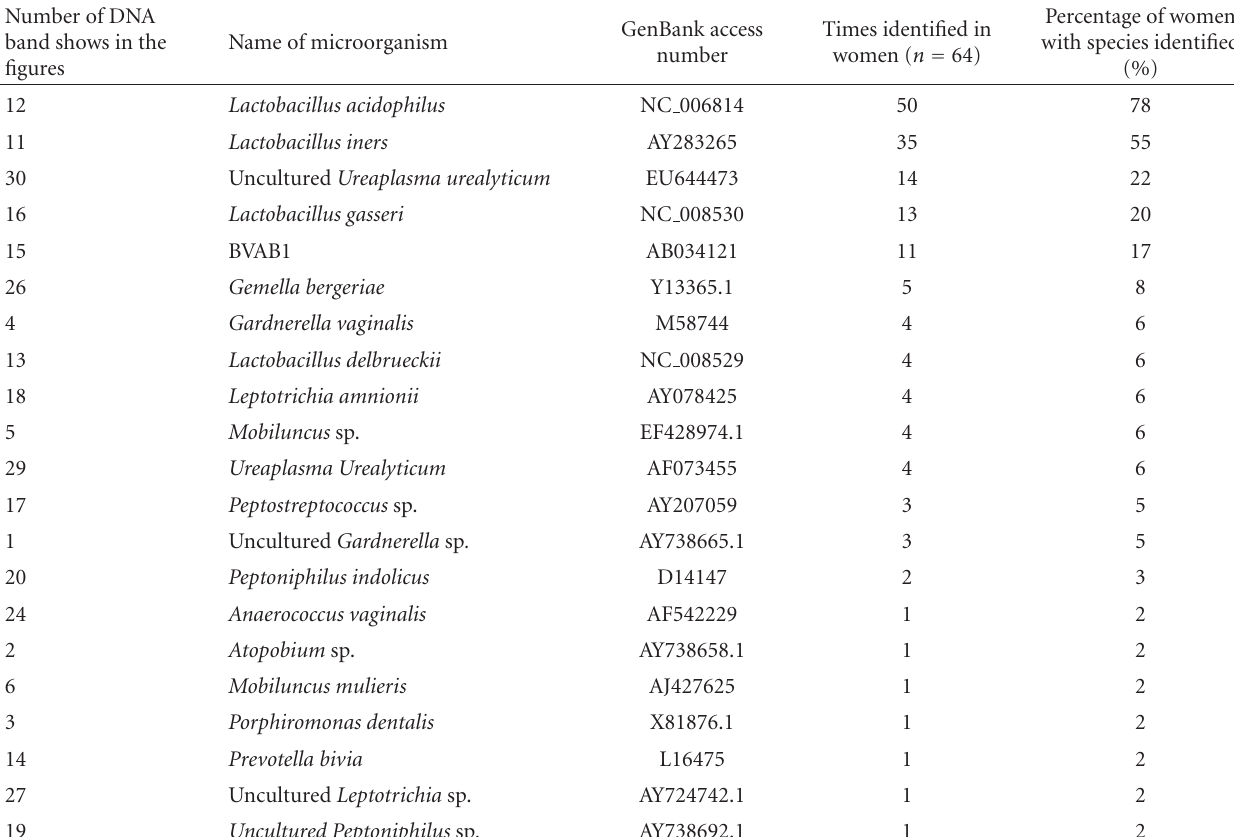
Table 2: Microorganisms identified in the vaginal tract of pregnant healthy women.